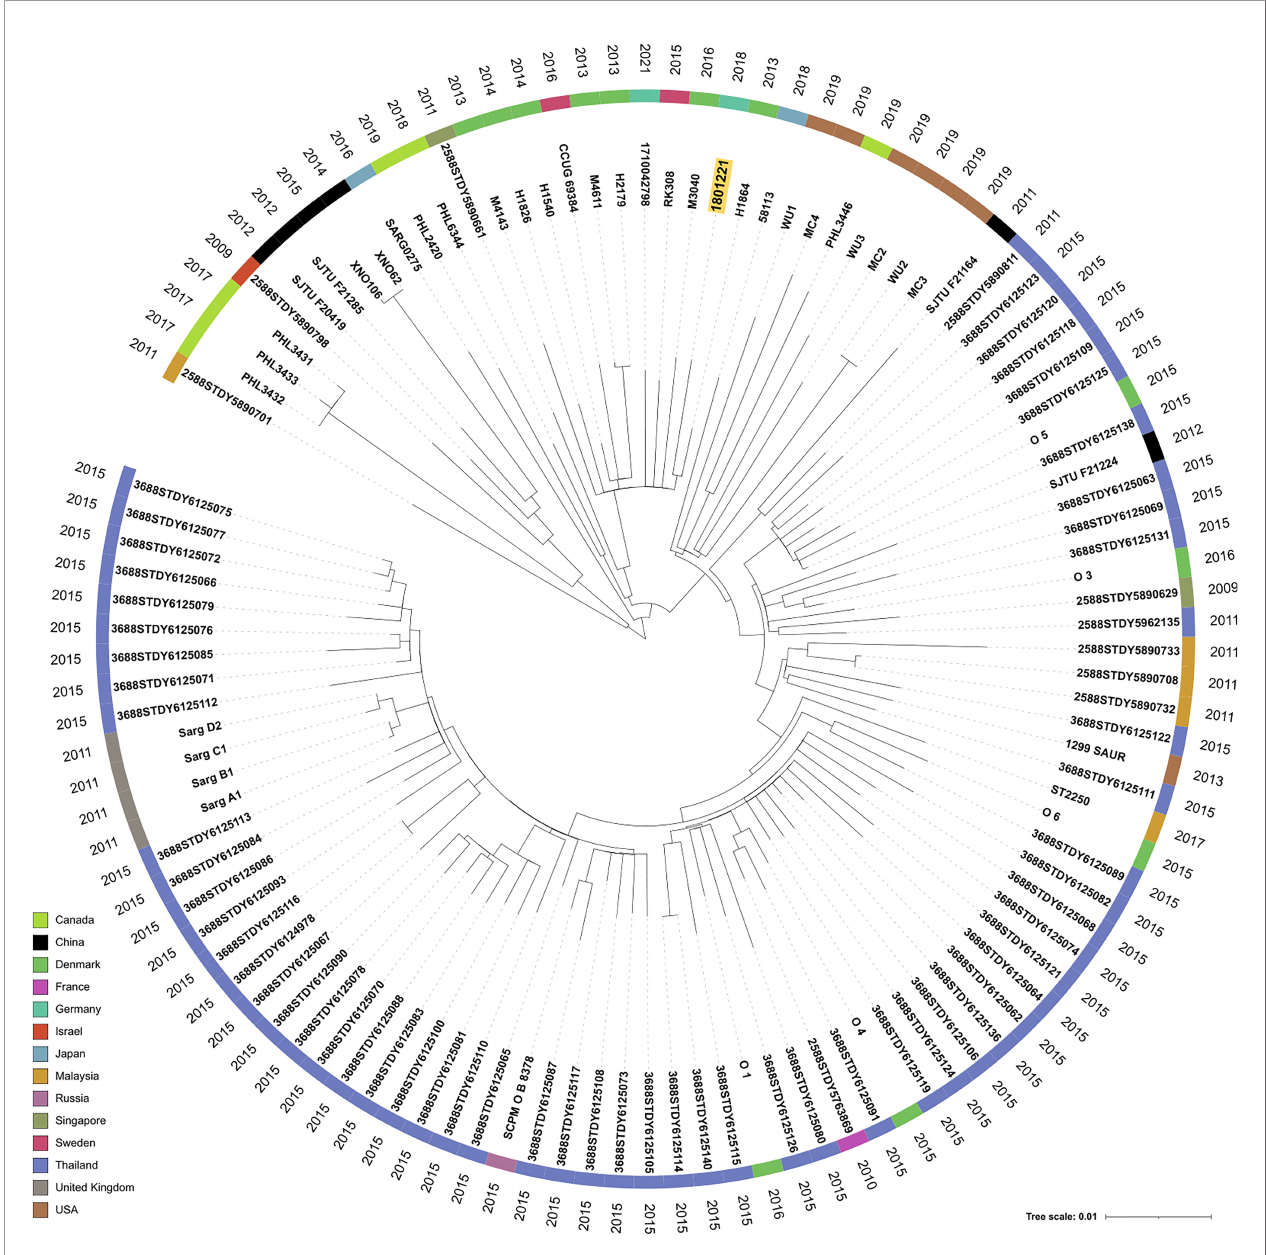
FIGURE 2 | Neighbor-joining (NJ) tree of 111 S. argenteus ST2250 global isolates. SNPs (n = 2,177) were extracted from 1,864 core genome genes present in all isolates and formed the basis to calculate the NJ tree with default parameters within the Ridom SeqSphere + software. We used iTOL V. 6 (Letunic and Bork, 2021) to display the tree and metadata of the strains. The leaves of the tree were annotated with the sample names. The colored circle indicates the country of isolation and the outer circle the isolation year, respectively. Isolate 1801221 is highlighted in a yellow